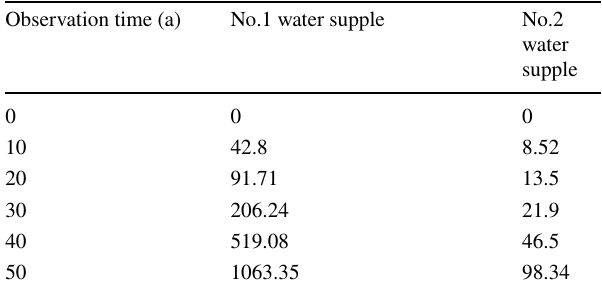
Table 2 Simulation results of each period